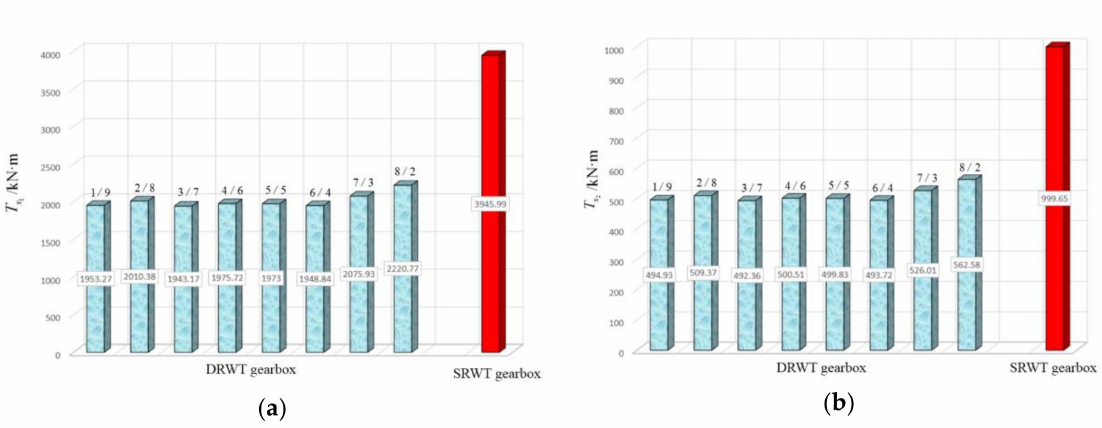
Figure 7. The torque transmitted by planet carrier: ( a ) first planetary stage; ( b ) second planetary stage.